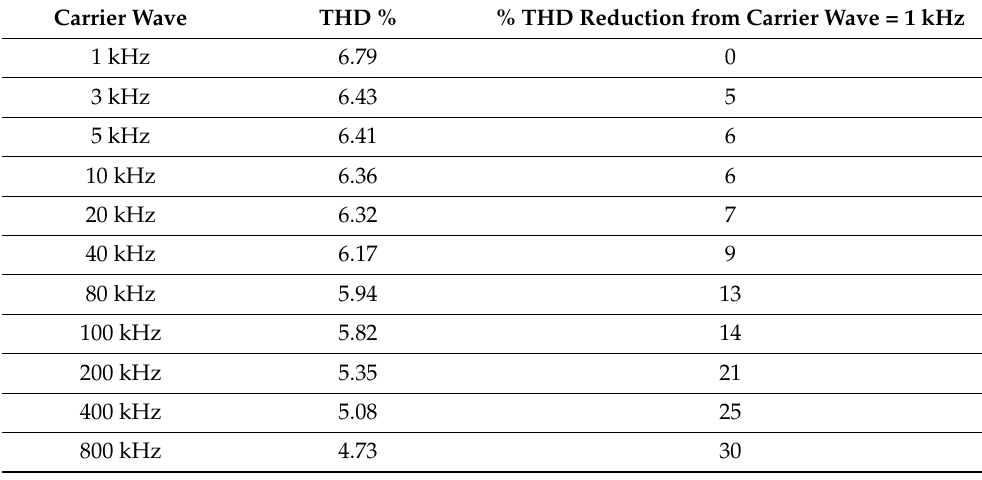
Table 10. Total harmonic distortion (THD) of the 21-level inverter for the SPWM digital switching controller at different carrier-wave frequencies (1 kHz to 800